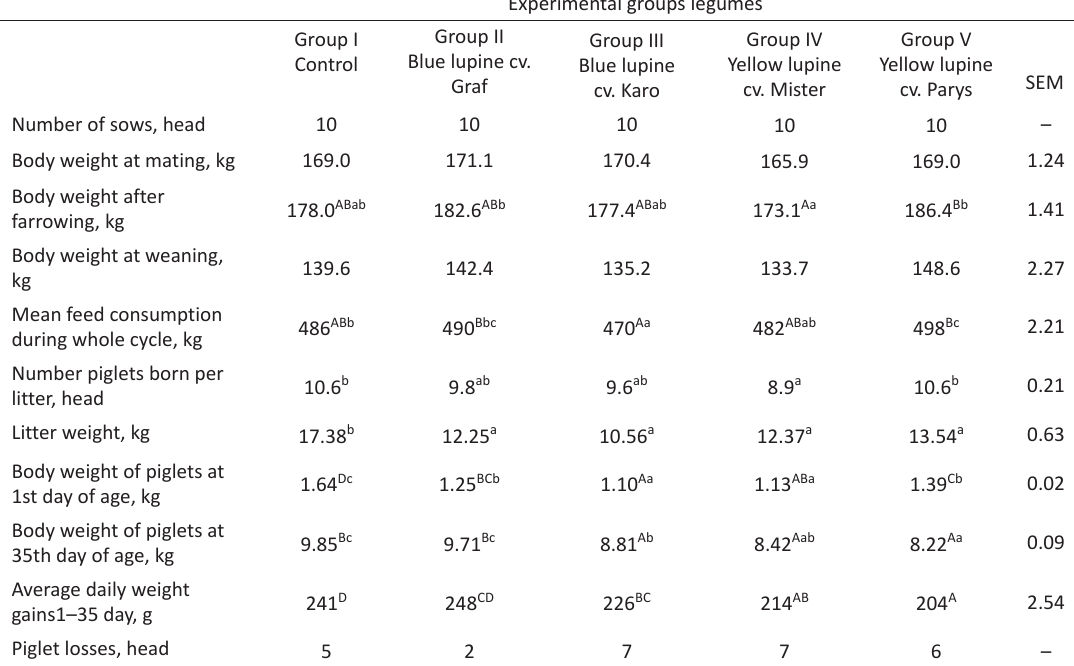
Experimental groups